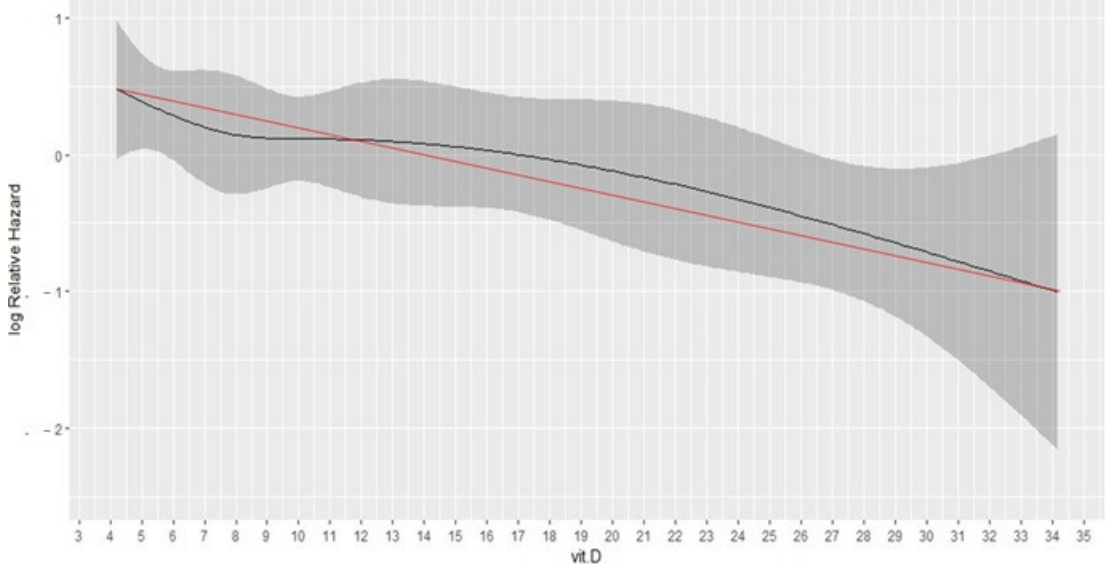
Figure 1. Hazard Ratio Smoothed Curve with Restricted Cubic Splines for the effect of continuous value of plasma 25(OH)D on overall survival. The graph demonstrates an approximately linear association with vitamin D (simplified by red straight-line). Vit.D: vitamin D; 25(OH)D: plasma 25-hydroxyvitamin